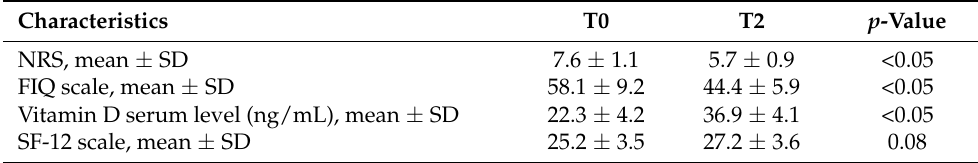
Table 3. Effects of vitamin D supplementation at 6 months in group